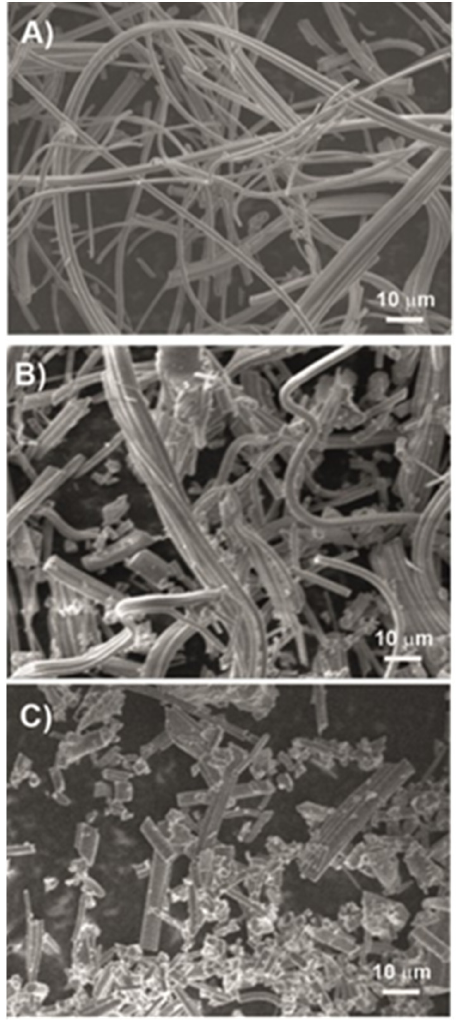
Figure 1. SEM images of ( A ) original inorganic fibers, ( B ) fibers milled for 5 s (L-SiO 2 NFs), and ( C ) fibers milled for 60 s (S-SiO 2 NFs).